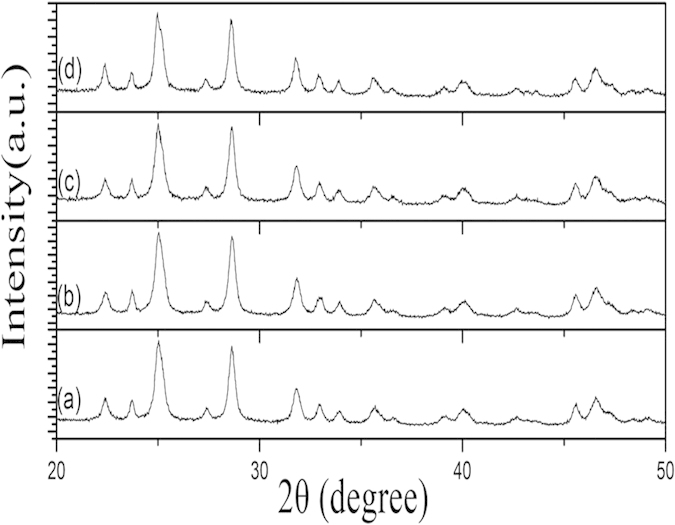
XRD patterns of Bi2S3:Eu3+ nanocrystals prepared at 180 °C for 12h with different Eu3+ concentrations: (a) 5%, (b) 10%, (c) 15%, and (d) 20%.